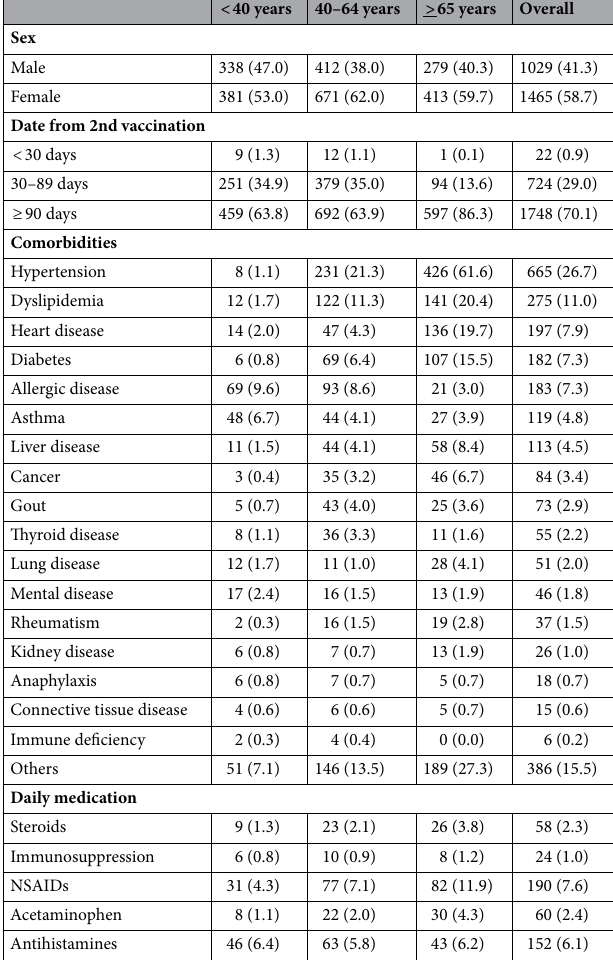
Table 1. Demographic and clinical characteristics of participants. NSAIDs, non-steroidal anti-inflammatory